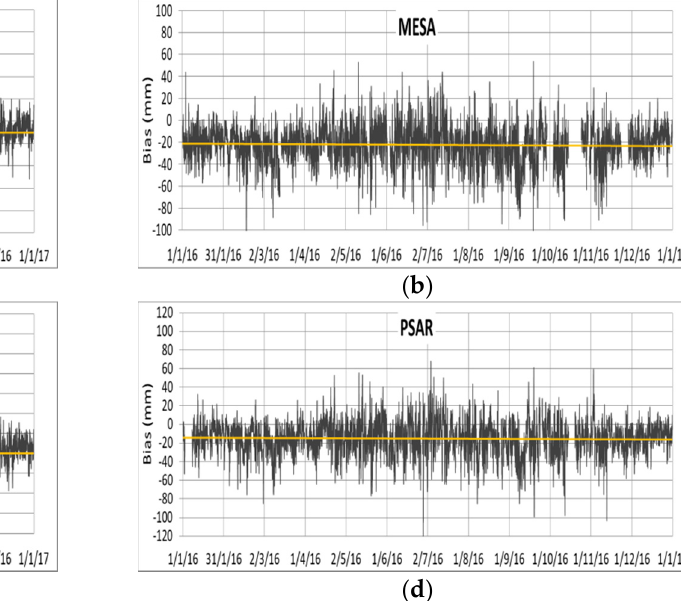
Figure 8. Bias plots of predicted (WRF MOD5) minus observed (GNSS) ZTDs at 4 PaTrop stations, KALA ( a ), MESA ( b ), EYPA ( c ) and PSAR ( d ) over Jan–Dec 2016. The yellow line indicates the mean bias (MB). Table 4. Statistical indices of complete WRF ZTS vs. GNSS ZTD time series—Jan–Dec 2016.